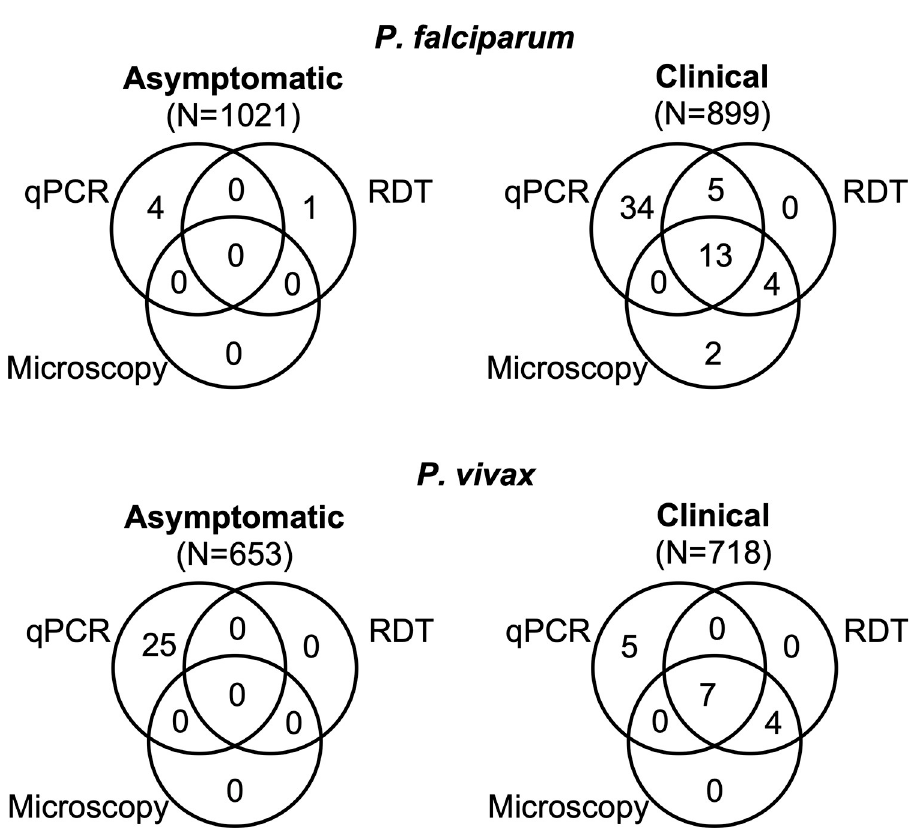
Fig 2. Number of samples positive by qPCR, RDT, and microscopy among clinical and asymptomatic individuals.